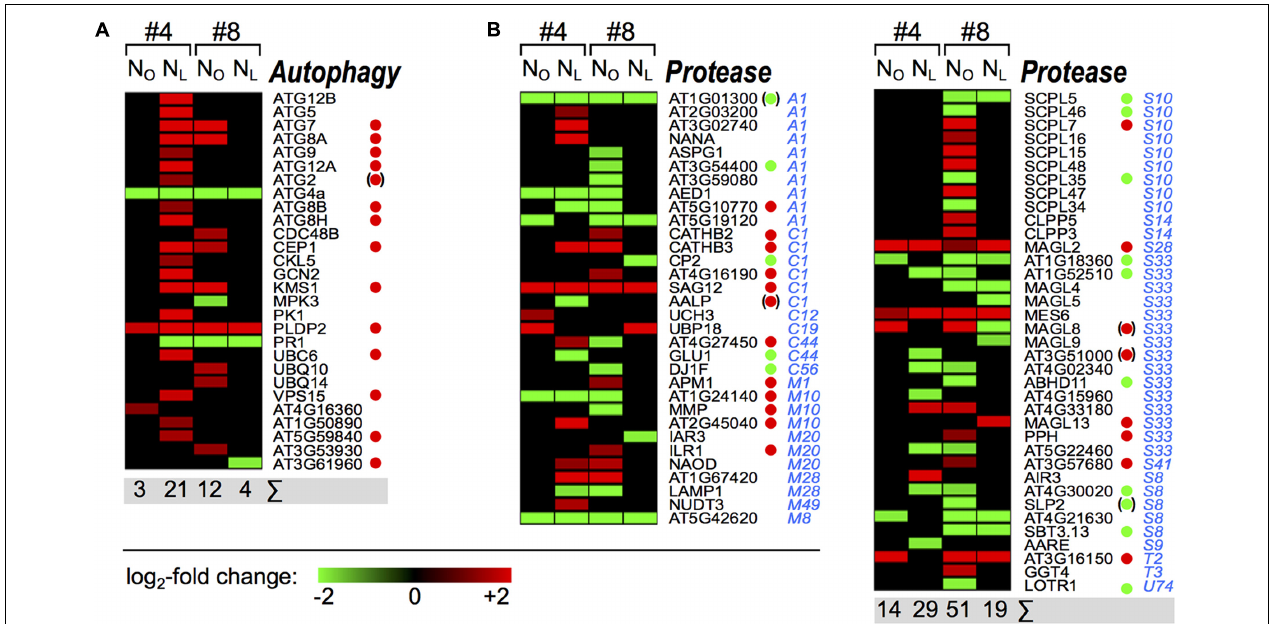
FIGURE 7 | Senescence associated oilseed rape autophagy and protease genes. The heat maps display the upregulated (red bars) or downregulated (green bars) Brassica napus unigene homologs of Arabidopsis thaliana (A) autophagy genes and (B) peptidase genes in leaf #4 between 92 and 99 DAS and in leaf #8 between 92 and 106 DAS as indicated on top of the columns. Peptidase family affiliations (MEROPS Peptidase Database) are indicated in blue letters. Depicted are genes with expression ratios ≥ 3 and P adj < 0.05 ( n = 3). Green and red dots denote genes that were reported as leaf senescence-associated down- and upregulated in Arabidopsis thaliana by Breeze et al. (2011). Dots in parentheses indicate that this gene was not steadily regulated in the course of leaf